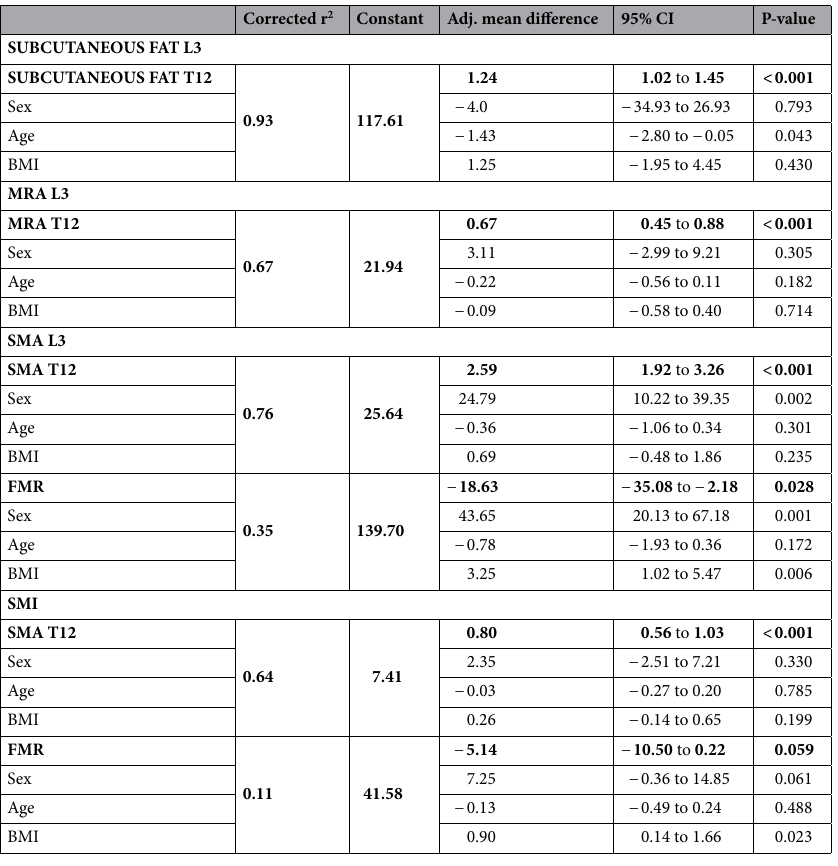
Table 2. Multivariable linear regression results of CT parameters. Results of the multivariable linear regression for CT parameters at T12 as independent variable and CT parameters at L3 as dependent variable (in bold letters) including the results of the adjusting variables sex, age, and body mass index (BMI) (not bold). Adj. mean difference = adjusted mean difference, CI = confidence interval, L3 = at the level of the third lumbar vertebra, T12 = at the level of the twelfth thoracic vertebra, MRA = muscle radiodensity attenuation in Hounsfield units, SMA = skeletal muscle area [cm 2 ], FMR = fat to muscle ratio calculated by waist circumference at the height of T12/((circumference of the right posterior paraspinal muscle + circumference of the left posterior paraspinal muscle)/2) according to Kottlors et al. 17